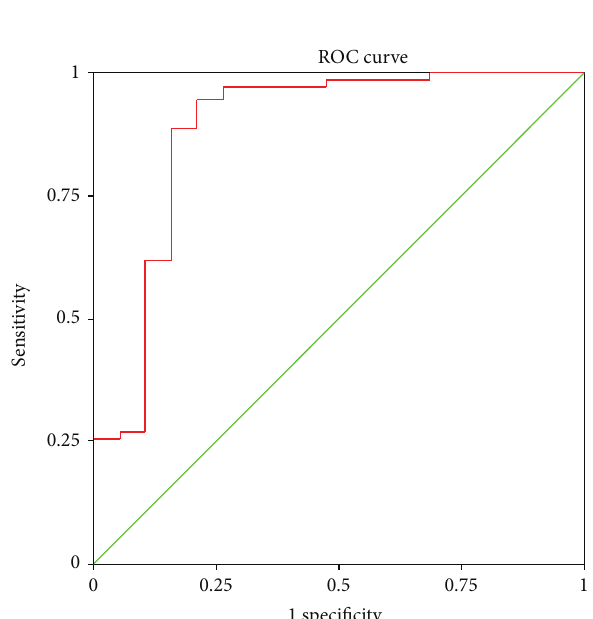
Figure 4: ROC curve for coapplying rabeprazole test and SF-36 in diagnosing GERD.